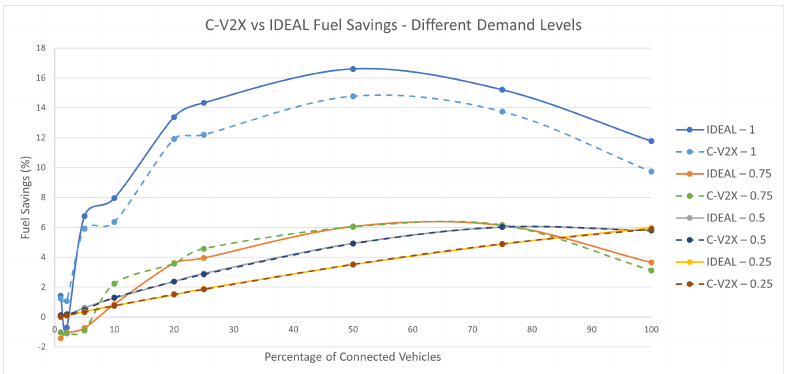
Figure 16. Average network-wide Fuel Savings of Energy-Efficient dynamic routing application using IDEAL and C-V2X communication on LA road network with different traffic demand scale factors.